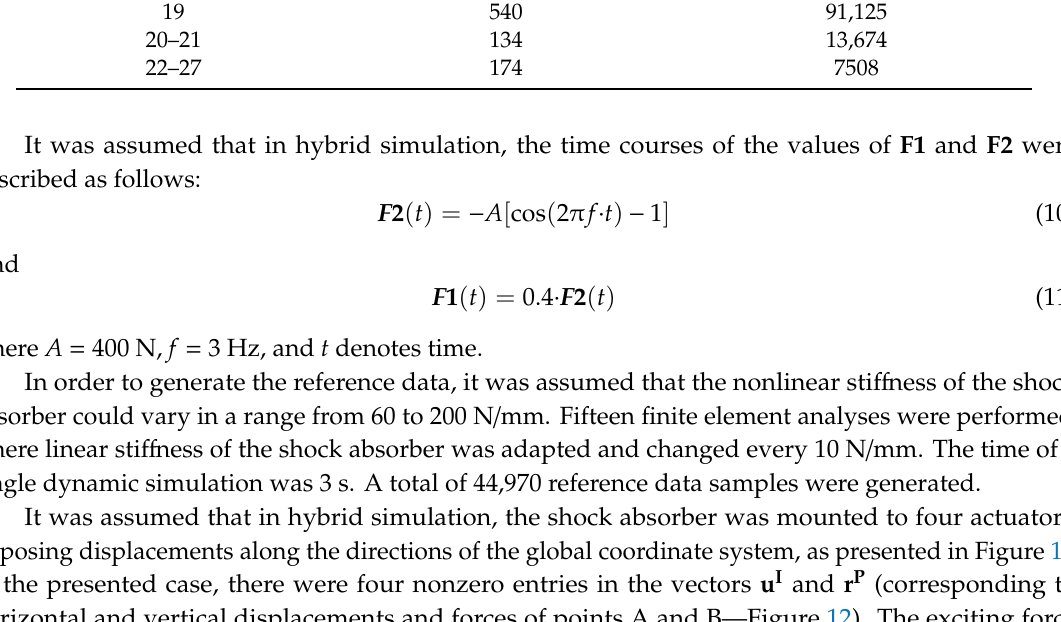
( b ) Figure 12. ANN obtained in example 2: ( a ) architecture, ( b ) performance of training. To verify the obtained ANN, the nonlinear elasticity of the shock absorber was described by the value of normal force generated in the element 17 N 17 (N) in the function of its elongation 𝜟 l 17 (mm). Two alternative functions were taken into consideration: 𝑵 (cid:2869)(cid:2875),(cid:2869) = 100𝛥𝑙 (cid:2869)(cid:2875) + (𝛥𝑙 (cid:2869)(cid:2875) ) (cid:2871) (12) and